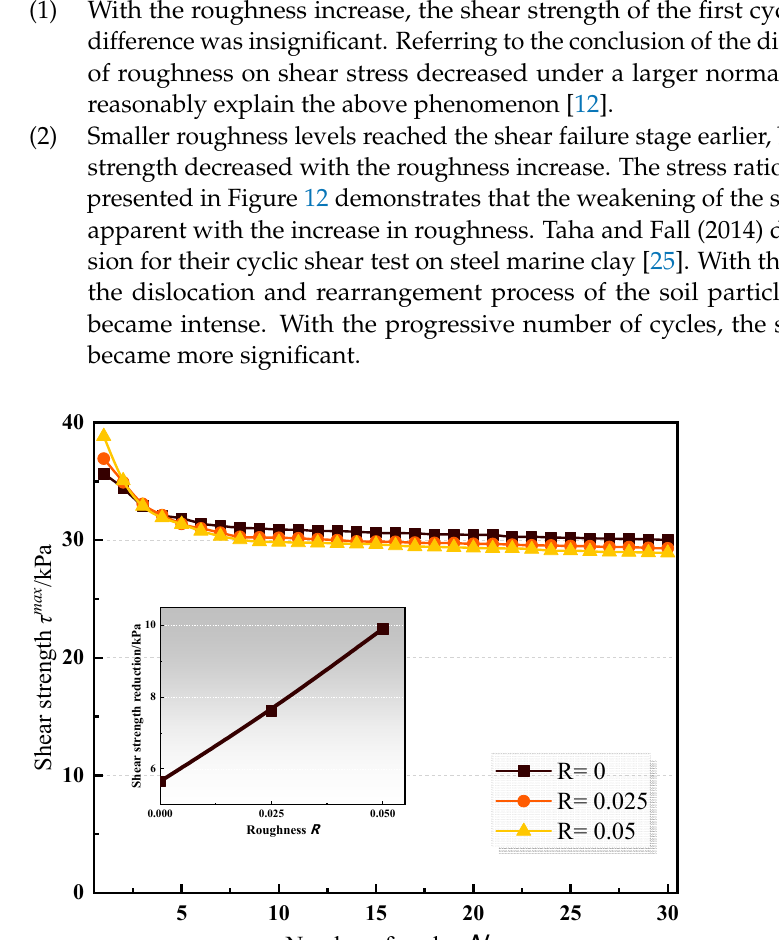
Figure 13. Stress ratio–number of cycles curve under different roughness levels. 3.1.4. The Influence of Water Content Figure 14 illustrates the shear strength–cycle number curve of test groups 6, 7, and 8 (where the water contents were 16%, 24%, and 20%, respectively). The results suggested that shear strength increased with the decrease in water content. However, the difference between the test results for the 16% and 20% water content levels was smaller than those of 20% and 24%. The shear behavior in the positive direction of the first cycle of the cyclic test was equivalent to that of the direct shear test. According to the conclusion of the direct shear test, the distinction mentioned above was induced by the optimal water content (19.6%) [12]. With the increase in water content, the cohesion first increased and then